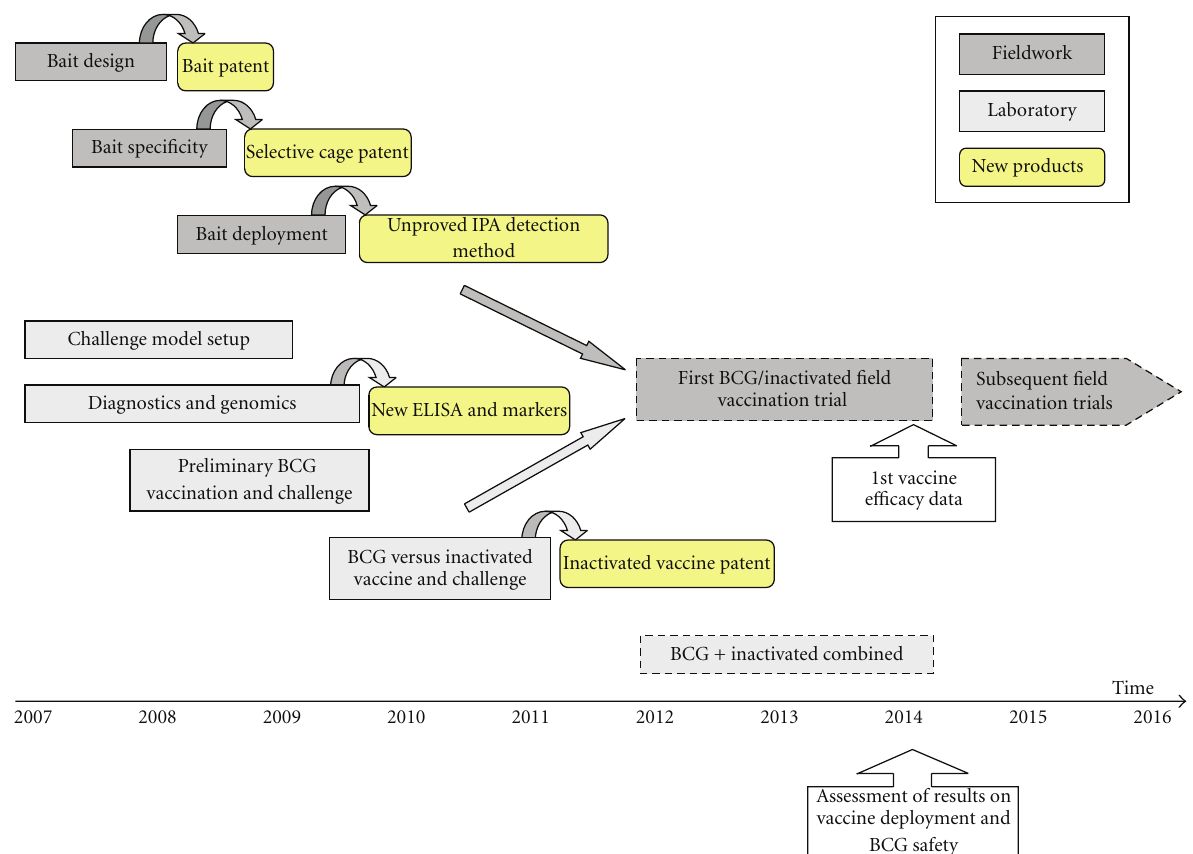
Figure 2: Flowchart of the laboratory and field research and key results towards oral vaccination of Eurasian wild boar against Mycobacterium bovis . Dashed boxes indicate future